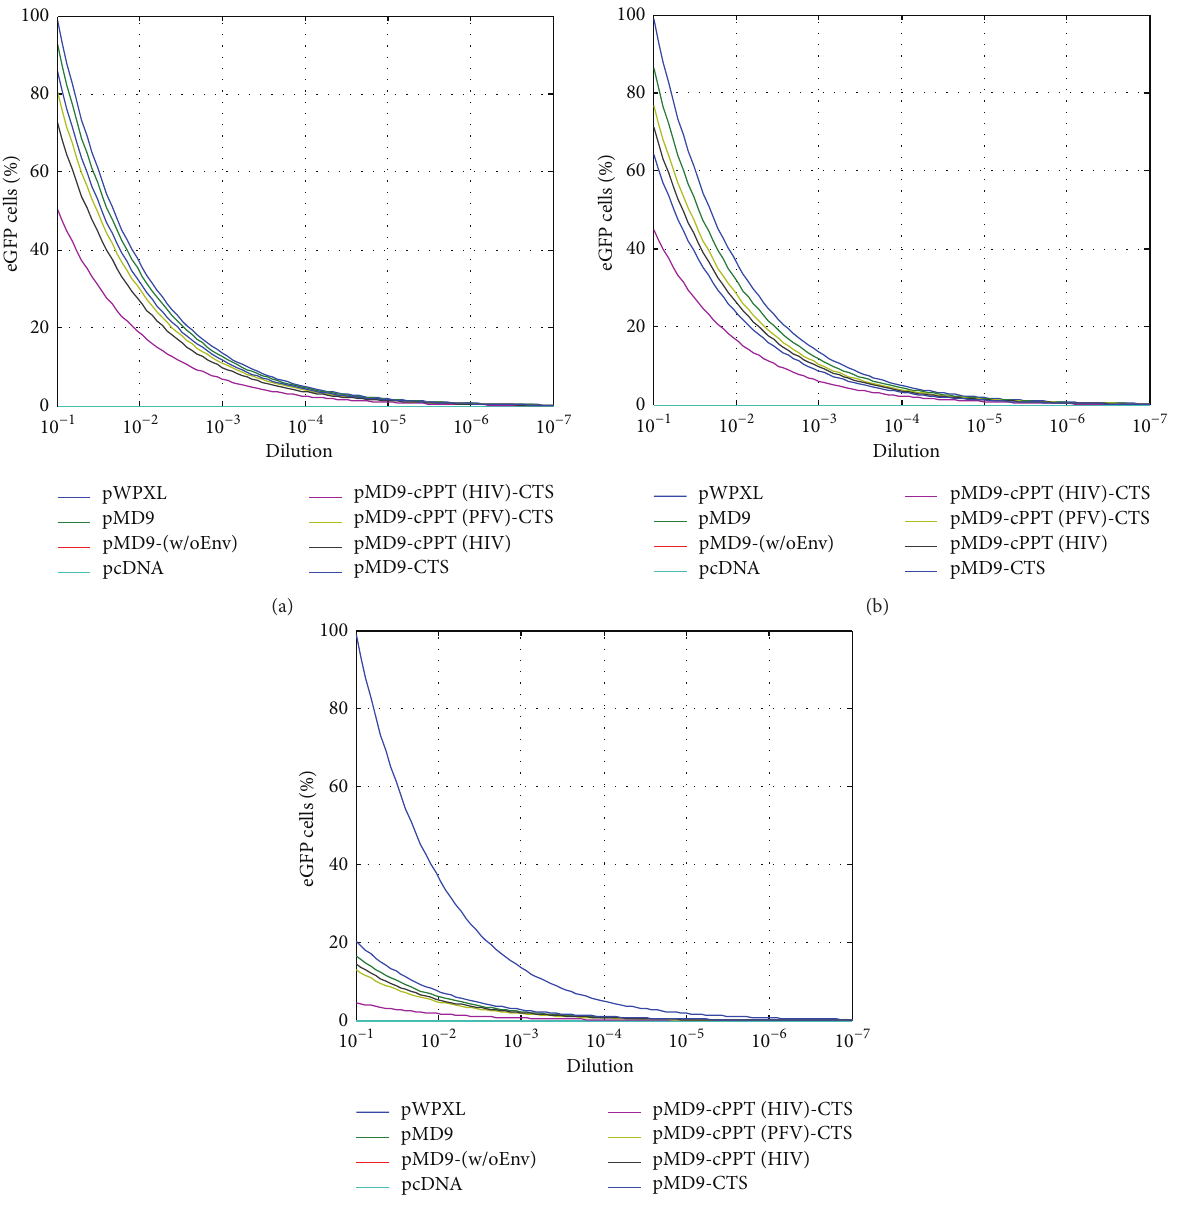
Figure 8: Dynamic 𝑓(𝑥) function: logistic dose-response curve to predict and model the viral titre. The pMD9-based vectors were tested to vt efficiently transduce dividing and growth-arrested cells (G 1 /S phase of cell cycle). Three conditions were analysed in the experiment: control (a); DMSO (b); aphidicolin